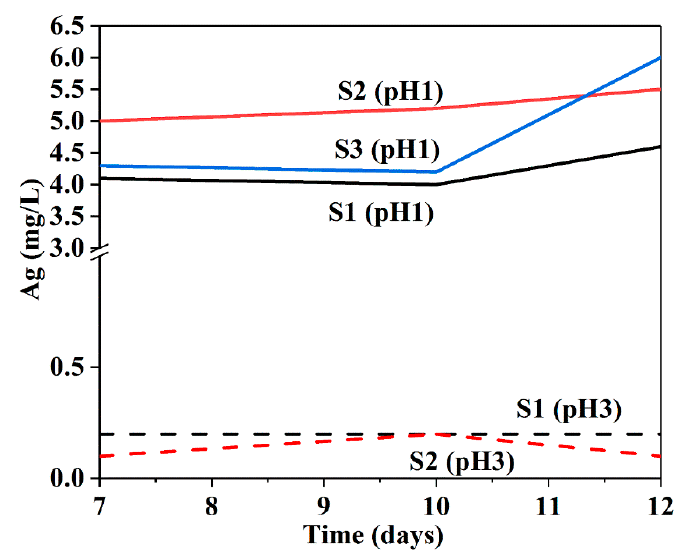
Figure 10. Release of Ag from S1, S2 and S3 at 7, 10 and 12 days under pH 1 acidic condition.